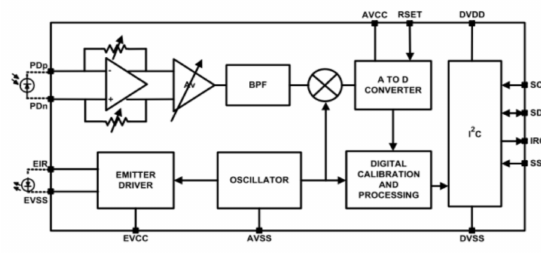
Figure 15. Architecture of Intersil ISL29501 SOC LiDAR